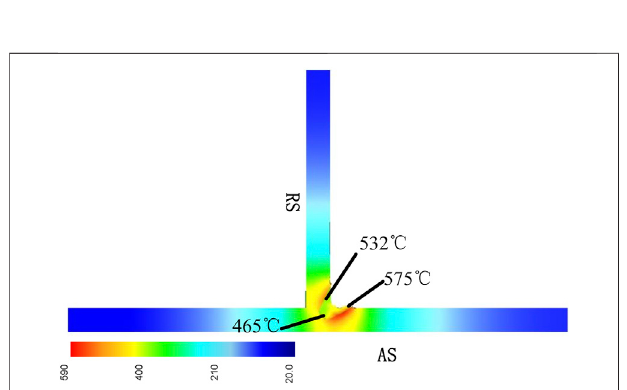
FIGURE 6 | Temperature distribution at the joint